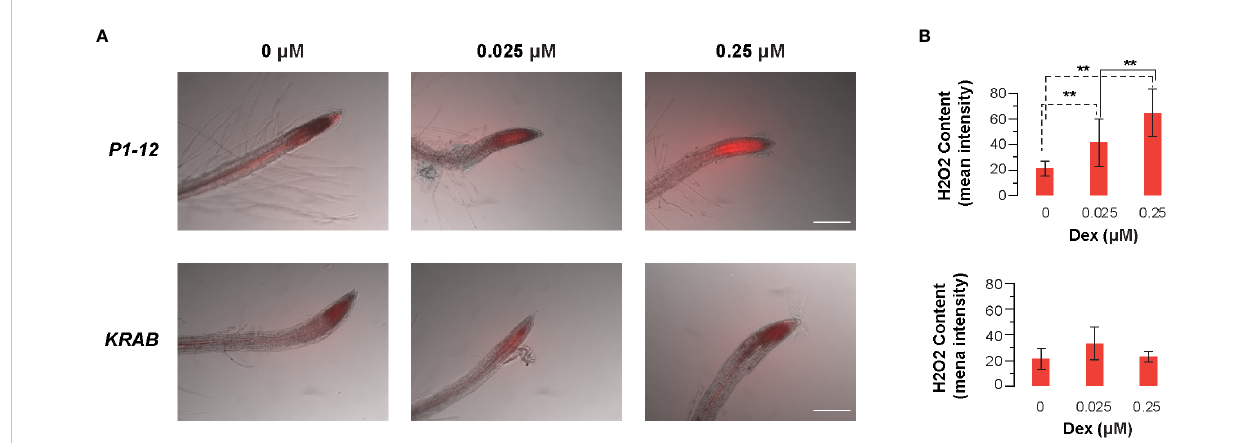
FIGURE 9 Dex-induced inhibition of MORF2 through dCas9-KRAB-mediated transcriptional repression in P1-12 increases accumulation of H 2 O 2 in root tips. (A) Merged images of bright fi eld (grayscale) and fl uorescence (red pseudocolor) showing localization and accumulation of H 2 O 2 at the root tip of 4-d- old P1-12 and KRAB seedlings treated with different concentrations of Dex. H 2 O 2 content was displayed by 2 m M CM-H2DCFDA for 10 min before microscopy examination. Fluorescence indicates the presence of H 2 O 2 . Scale bar = 100 m m. (B) Quanti fi cation of H 2 O 2 content in root tips. To avoid the size veri fi cation of root tips, average fl uorescence intensity of a fi xed area (0.1 mm x 0.25 mm) that includes ~ 0.2 mm of root tip was measured using ImageQuant5.2 and used to re fl ect the relative H 2 O 2 content. In total 10 seedlings were analyzed for each data point except for KRAB (+0.025 M Dex), in which 9 seedlings were analyzed. Fluorescence images of all the replicates are presented in Figure S6. **: P < 0.01 (Student's t-test,